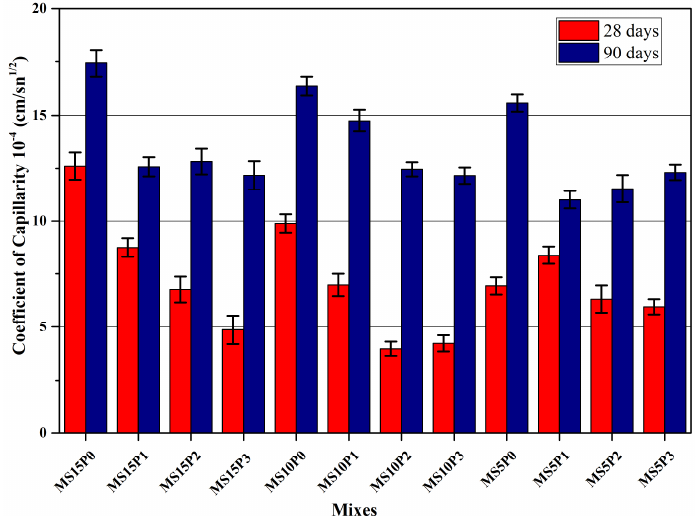
Figure 25. Capillary water absorption values of the MS samples .